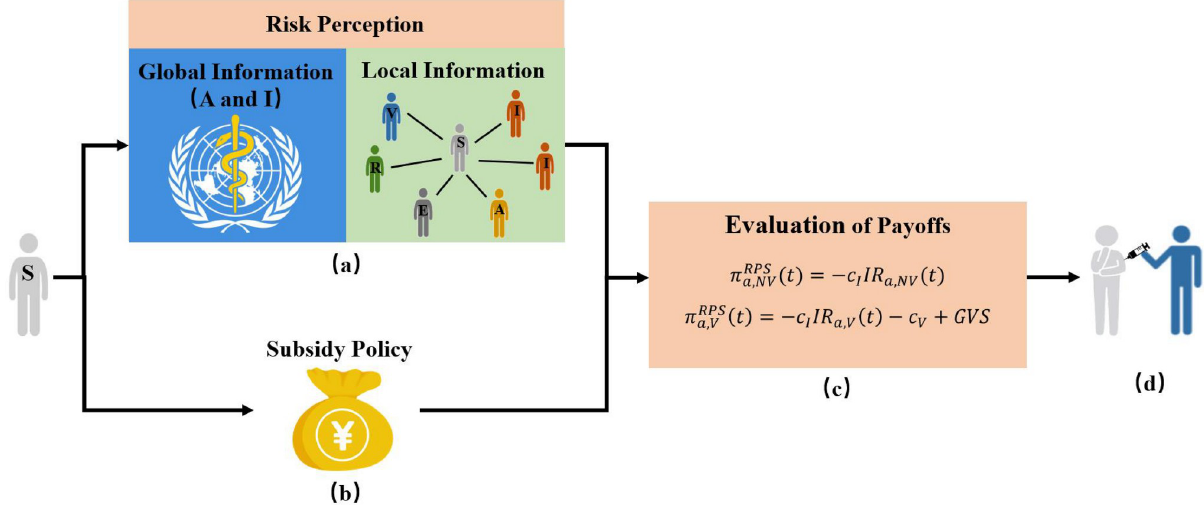
Fig 3. Schematic representation of the Risk Perception with Subsidy Policy ( RPS ) vaccination strategy under different information sources. Individuals decide to be vaccinated by calculating the payoffs with or without vaccination based on both infection risk perception and subsidy policy. The infection risk is perceived by the epidemic severity formulated by the information, which is classified as global information released by Public Health Bureau and local information from first-order neighbors. (a) The information sources obtained by individuals is used to perceive the infection risk; (b) The subsidy policy from government; (c) Evaluation of payoffs for unvaccinated and that of vaccinated individuals at time t ; (d) Individuals determine to take the vaccinate or not.